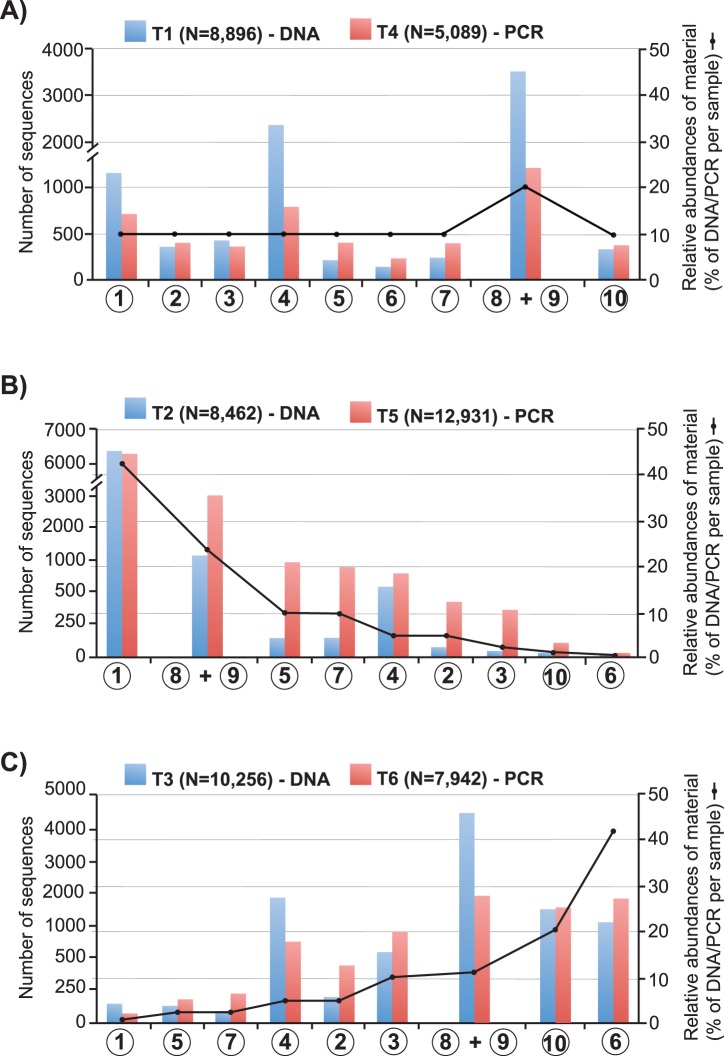
Contrived community experiment.Histograms show the number of recovered sequences per investigated species (circled numbers; see Figure 1) and for pooled DNA (T1, T2, T3) and pooled PCR (T4, T5, T6) treatments at A) equimolar, B) decreasing, and C) increasing concentration of starting material (shown in relative abundance of DNA/PCR products; see doted line and vertical scale on right of graphs). Two species, Perna perna and Perna canaliculus, were pooled together due to lack of SSU marker differentiation.